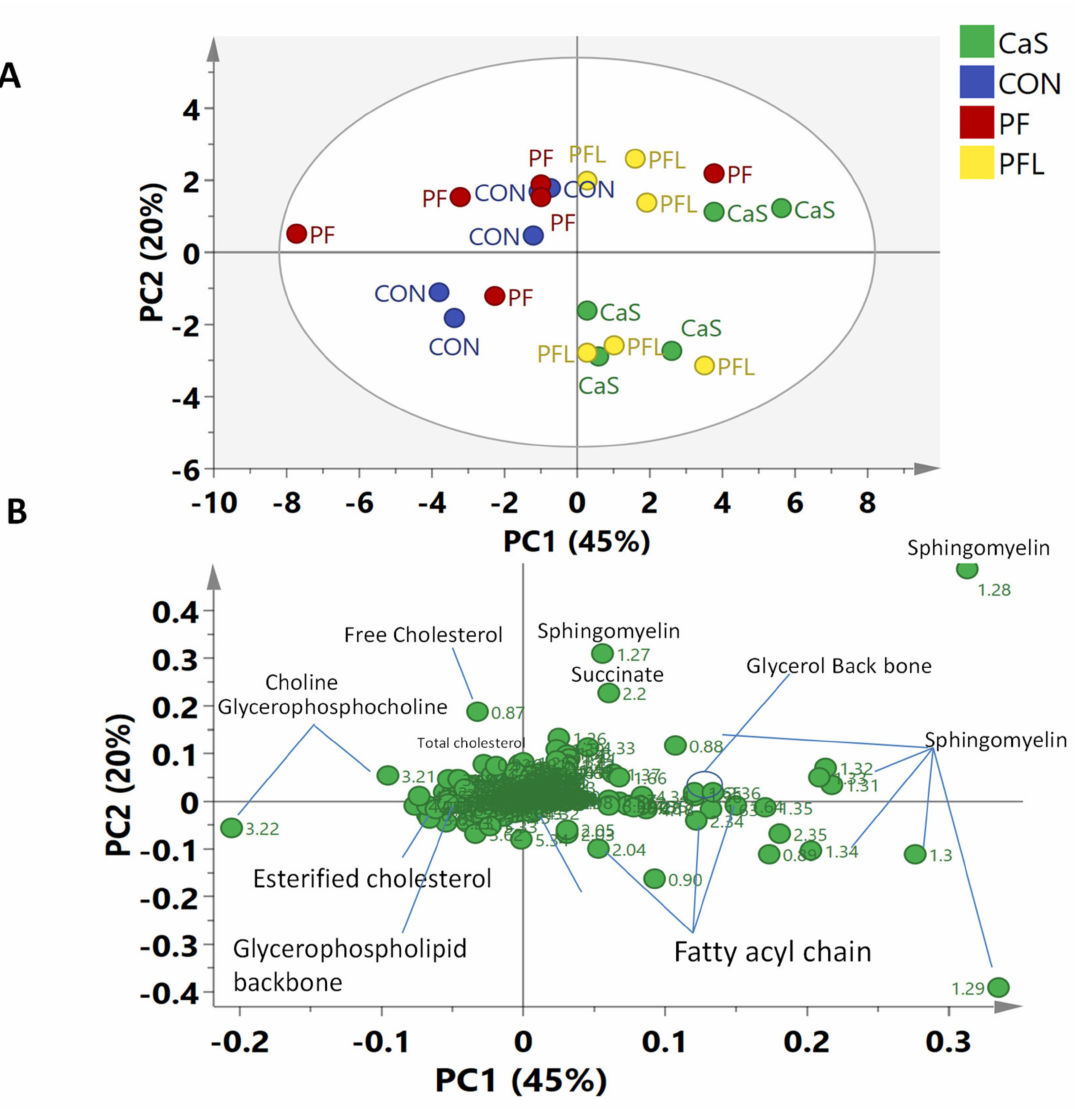
Figure 5. ( A ) Score plot of longissimus dorsi muscle of Dorper sheep. (PC1 = 45%, PC2 = 20%); CON = Basal diet without RBF, PF = Basal diet plus prilled fat, PFL = Basal diet plus prilled fat with lecithin, CaS = Basal diet plus calcium soap. ( B ) PCA Loadings scatter plot of Dorper sheep longissimus dorsi